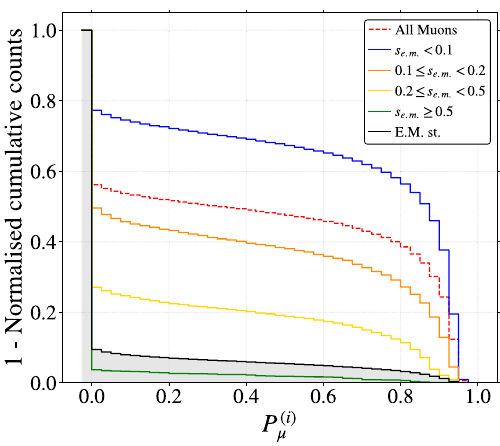
Fig. 5 Distribution of the probability P μ after evaluating all the sta- ( i ) tions of the array for gamma and proton induced showers with energies μ . Stations from